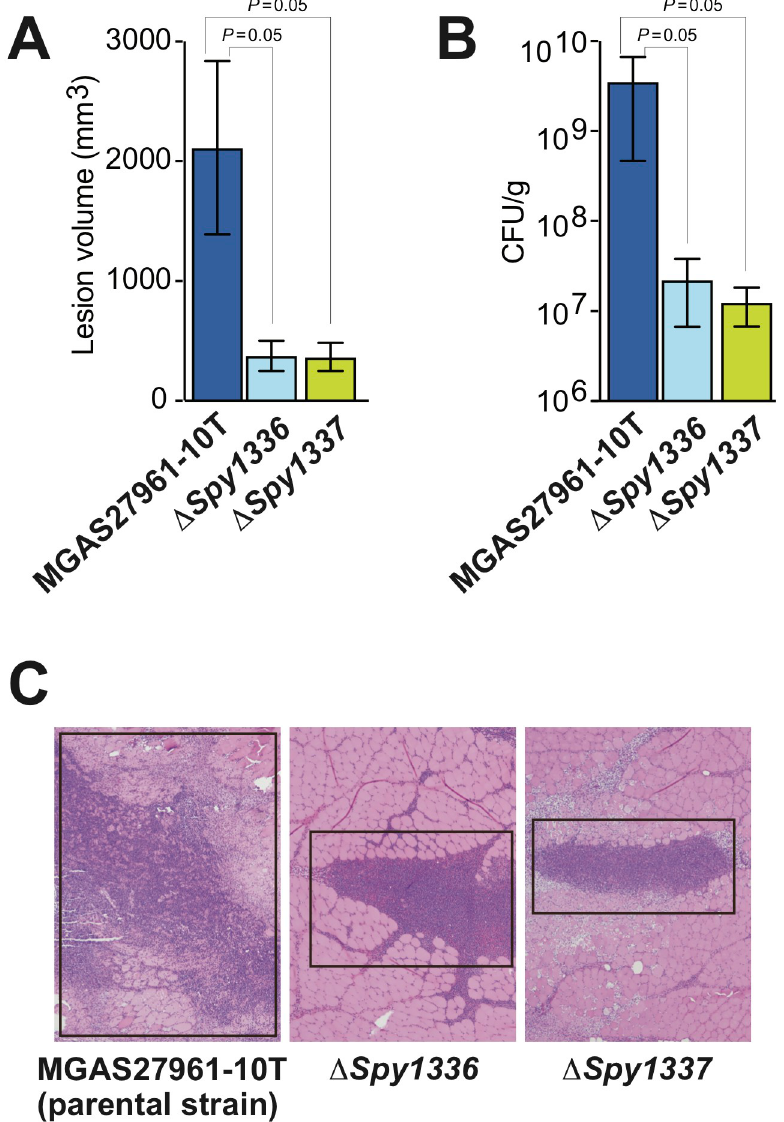
Fig 7. Virulence assessed in a nonhuman primate model of necrotizing myositis. Compared to the parental wild- type strain, deletion of Spy1336/R28 ( Δ Spy1336 ) or Spy1337 ( Δ Spy1337 ) significantly decreases (A) lesion volume, (B) CFU recovery, and (C) tissue destruction. Shown in panel C are representative microscopic images of the necrotic lesion centered at the GAS injection site (black box); hematoxylin and eosin stain, original magnification 4X. P = 0.05, Mann-Whitney Test. n = 3 NHPs/GAS